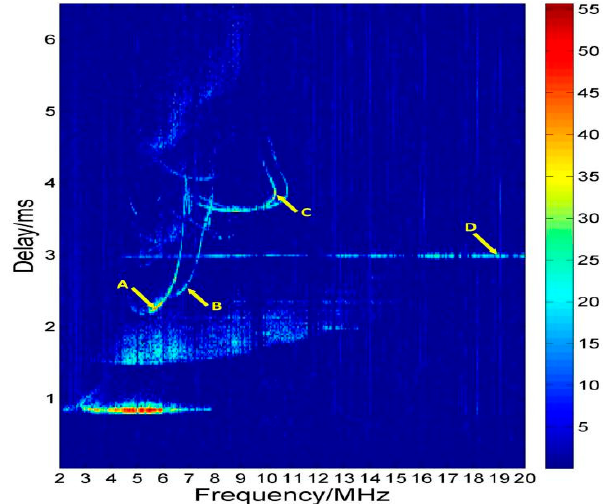
Figure 4. Ionogram of the same complementary code sequence.